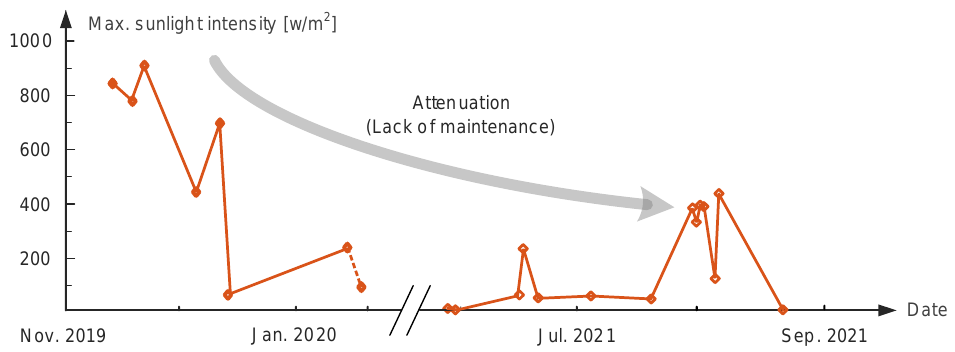
Figure 2. Sunlight intensity data as a function of date. to date and it yields a diagram of changing relationship. It can be seen that the tower environment has wind in every season, and the range of wind speed is from 0.5 m/s to 5 m/s, which is not a dramatic change. Furthermore, most of the time, the average wind speed changes between 1 m/s and 3 m/s. In consequence, wind energy is harvested in our proposed method to offset the loss of solar energy by analyzing the features of wind speed.